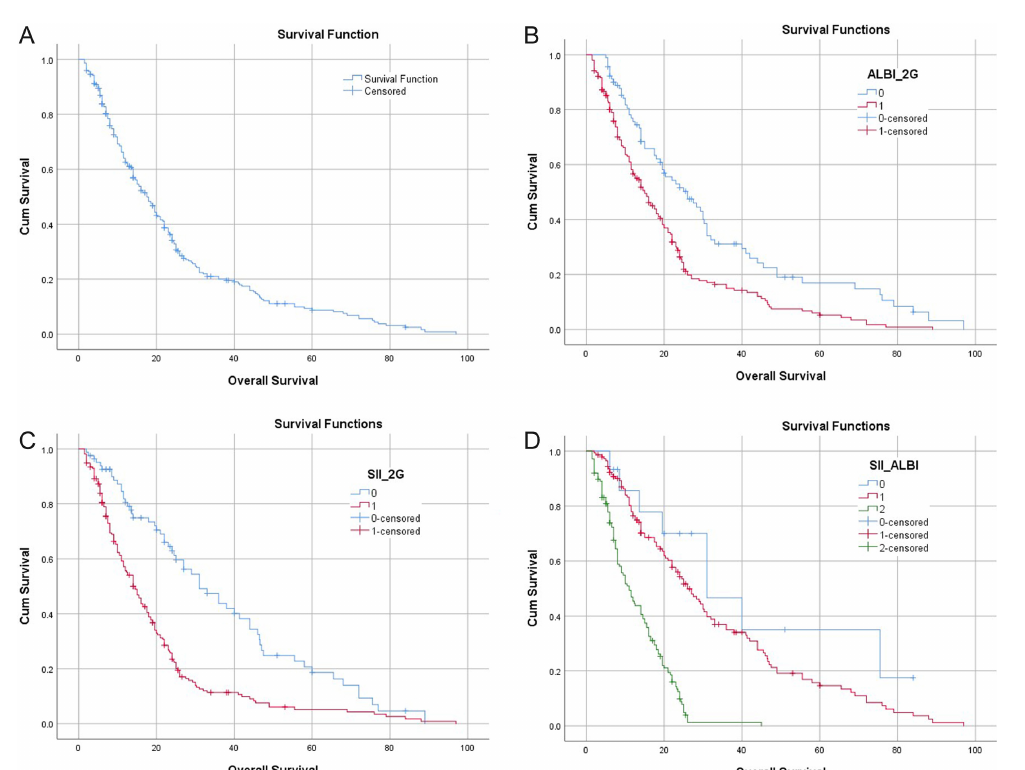
Figure 2. Overall survival curves in HCC subjects being treated with transarterial chemoembolization for hepatocellular carcinoma via the Kaplan-Meier approach. (A) Overall survival; (B) SII; (C) ALBI grade; and (D) SII-ALBI. HCC, hepatocellular carcinoma; SII-ALBI, systemic immune-inflammation index along with albumin-bilirubin scores.